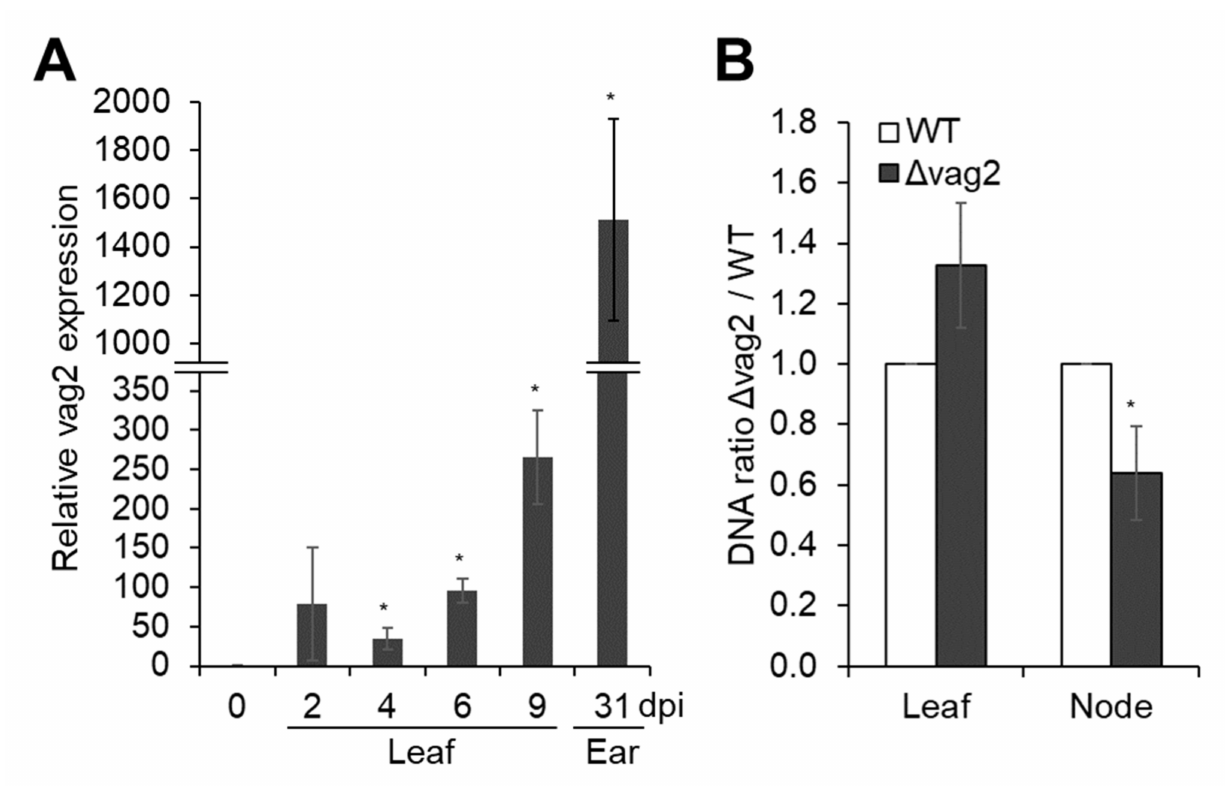
Figure 3. Quantification of vag2 mRNA and fungal DNA in inoculated maize seedlings. ( A ) Relative expression of vag2 ( sr10050 ) in S. reilianum -inoculated Z. mays cv. ‘Gaspe Flint’ tissues. Samples were harvested from a mating mixture of sporidia grown in liquid culture (0 dpi), from inoculated maize leaves at 2, 4, 6, and 9 dpi, or from ears of inoculated plants at 31 dpi. Total RNA isolated from collected samples was used for quantitative RT-PCR. The expression of vag2 in all samples was normalized to expression values of the S. reilianum glyceraldehyde 3-phosphate dehydrogenase (GAPDH) gene ( sr10940.2 ) and is represented relative to the expression value of axenic culture. Error bars represent the SEM of three biological replicates. Each biological replicate is a pool of at least 10 tissue samples of independent plants. ( B ) Proliferation density of ∆ vag2 deletion strains ( ∆ vag2) in leaves and nodes of colonized Z. mays cv. ‘Gaspe Flint’ relative to wildtype (WT) strains. Total DNA was isolated from 3-cm pieces of inoculated leaves at 3 dpi and of nodes at the base of inoculated leaves at 14 dpi. The fungal GAPDH and maize actin genes were used to quantify relative fungal proliferation by quantitative PCR. The ratio of the fungal proliferation of ∆ vag2 deletion strains relative to wildtype strains was calculated as a measure of proliferation density. Error bars represent the SEM of three biological replicates. Each biological replicate is a pool of 10 samples from different plants. Data were analyzed with Student’s t -test (* p <